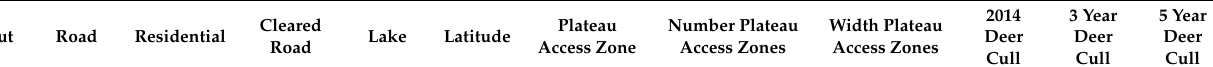
Table A1. Correlation coefficients ( r ) and p -values (shown in parentheses) are shown for each predictor.